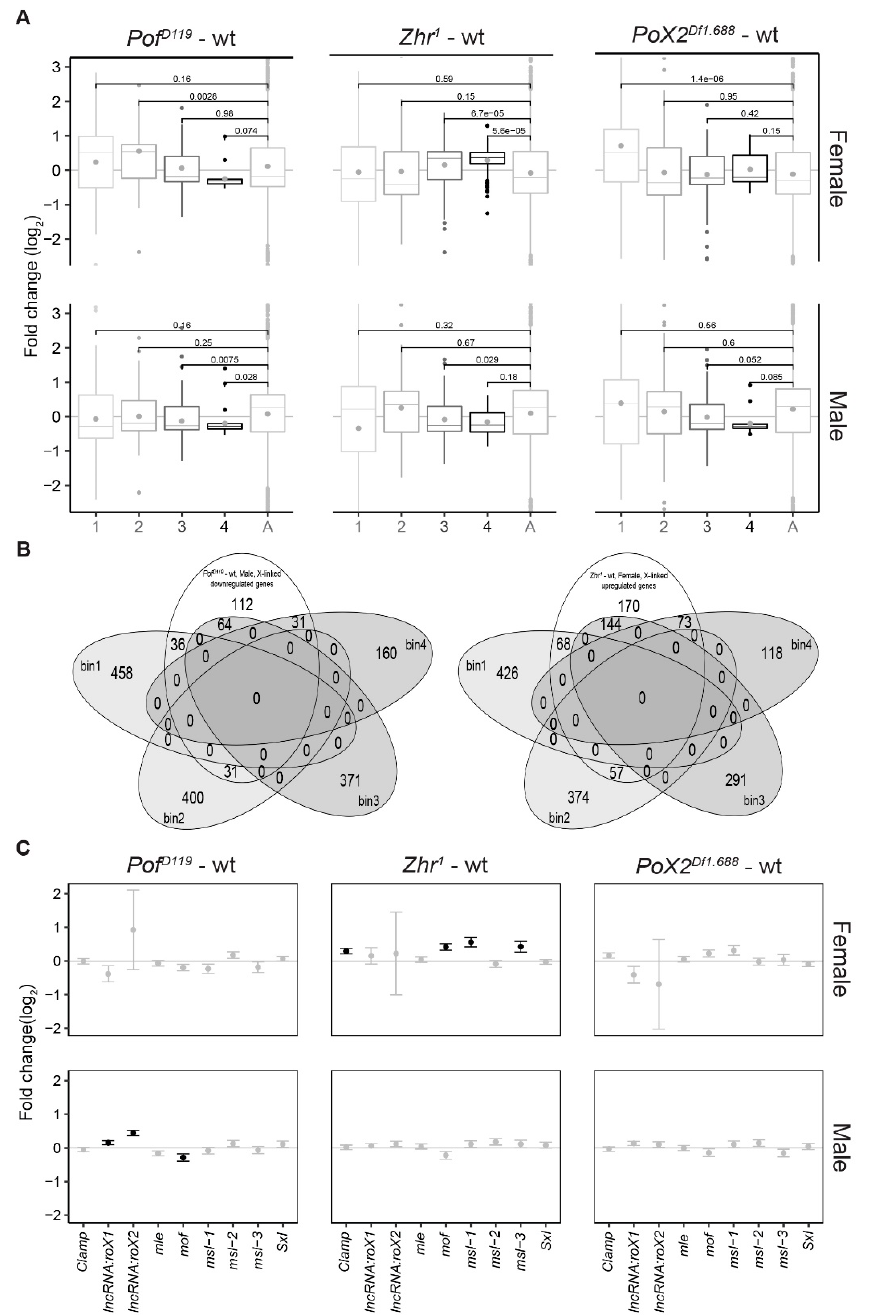
Figure 4. Relationship between X-chromosome specific effects and MSL (Male-Specific Lethal) binding levels. ( A ) Box plots representing average expression ratios of X-chromosomal genes binned based on their MSL binding strength (1 lowest to 4 highest). ‘A’ indicates the autosome chromosome arms combined (2L, 2R, 3L, and 3R). The MSL binding strengths from weakest to highest are shown by light grey to black, gradually. The box plots display median (line), average (dot), first and third quartiles (box), highest/lowest values within 1.5 × interquartile range (whiskers), and outliers. The statistical significance was determined by Wilcoxon signed-rank test and p-values are indicated. ( B ) Venn diagrams showing the number of downregulated genes on the X-chromosome in each MSL binding bin in Pof D119 -wt males (left) and upregulated genes in Zhr 1 –wt females (right). ( C ) Expression analysis of the individual genes involved in the X-linked dosage compensation in the mutants versus wild type. The grey standard error bars refer to the non-significant changes ( P adj > 0.05) and black indicate significant changes ( P adj < 0.05).